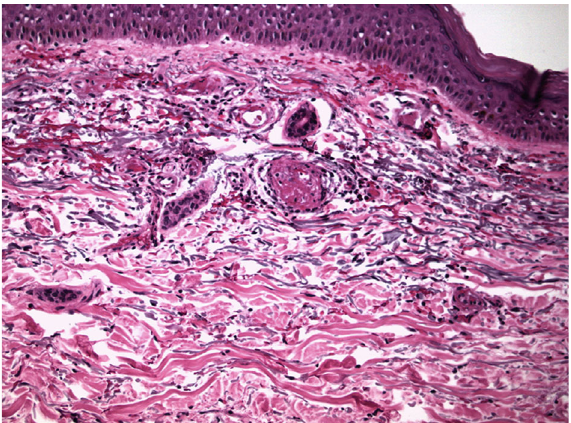
Figure 2: Endovascular fi brin clots. Generalized in fl ammation with a mainly perivascular